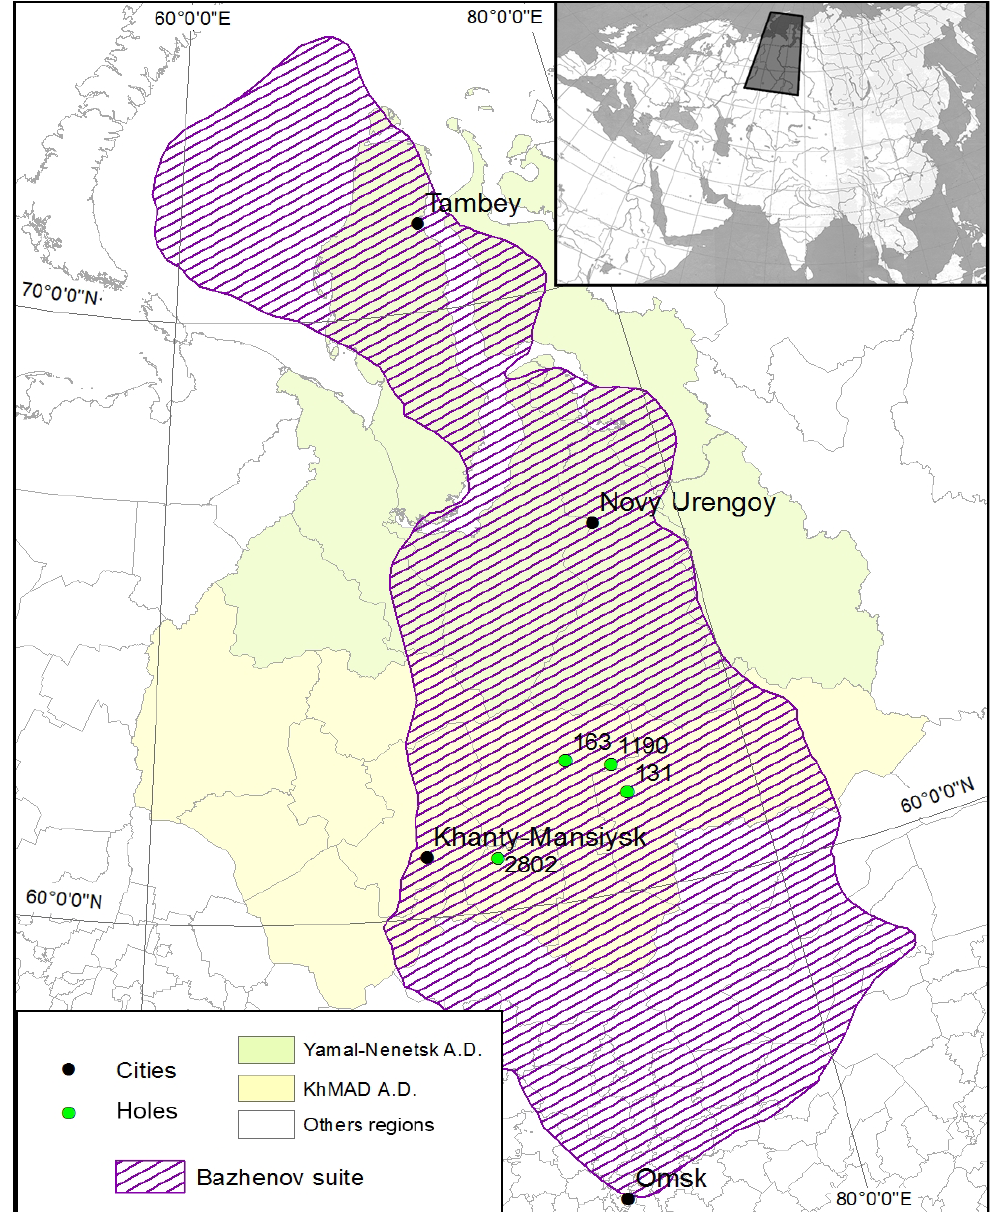
Figure 1. Map of Bazhenov Formation sediments on the West Siberian plate in Russian Federation.